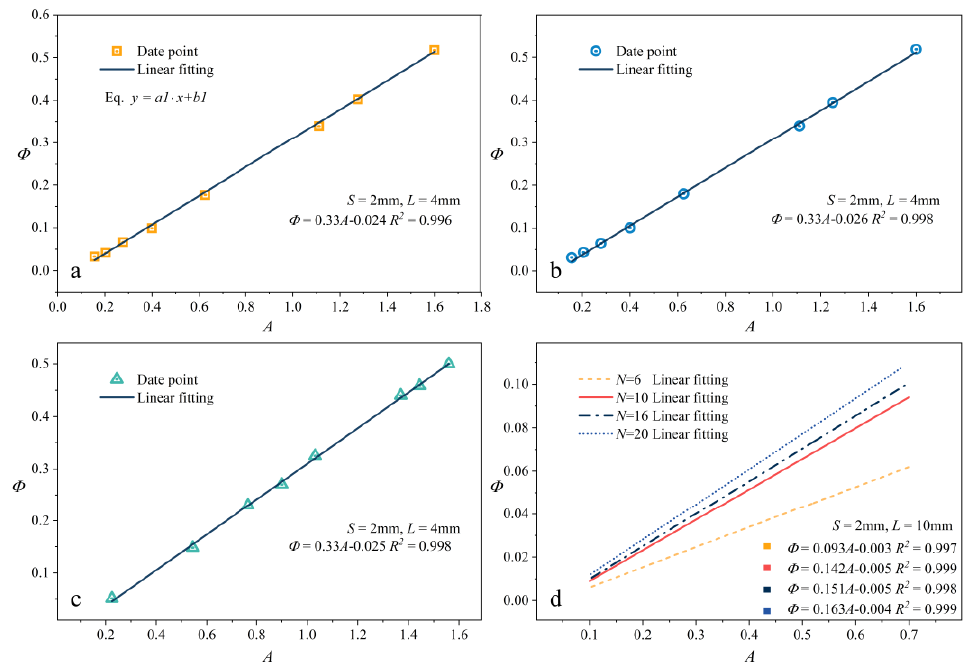
Figure 6. Study of the relationship between A and Φ . ( a ): Change D in parameter A ; ( b ): Change d in parameter A ; ( c ): Change D and d in parameter A ; ( d ): Change N in parameter A .